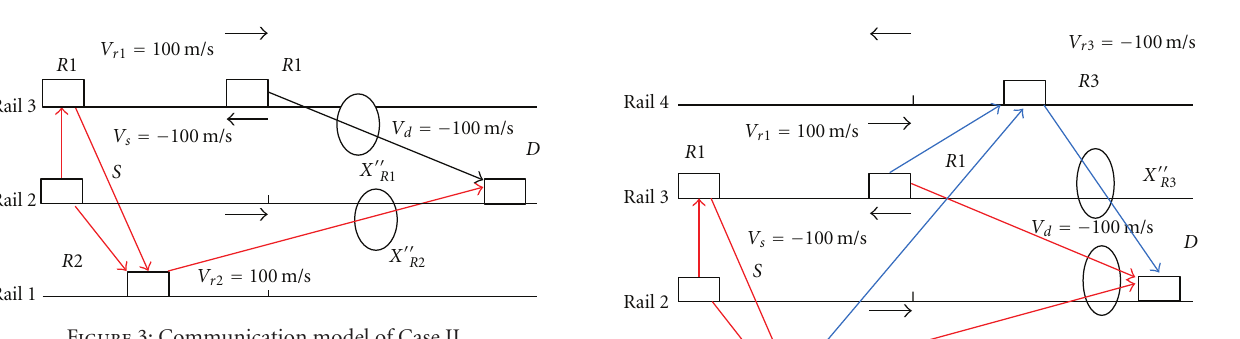
Figure 3: Communication model of Case II.